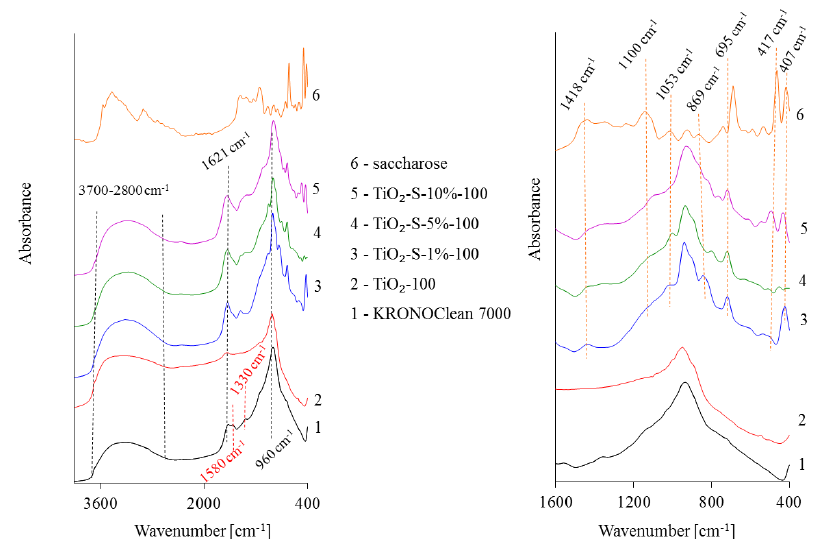
Figure 1. FT − IR/DR spectra of tested samples.